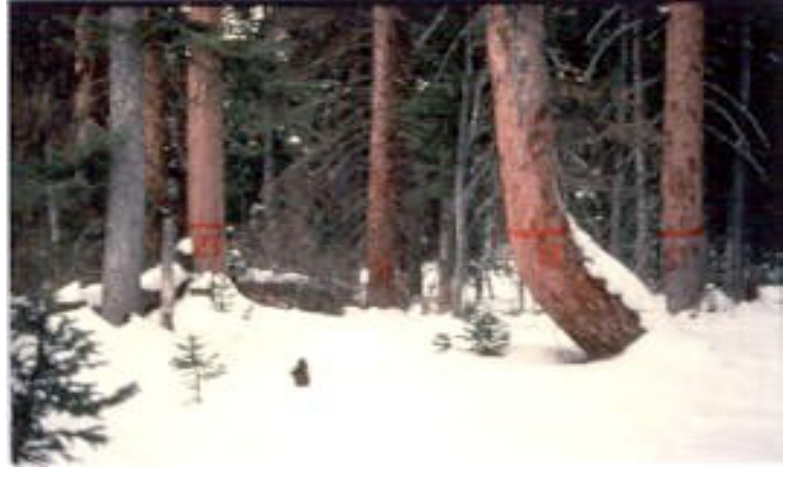
Figure 7. Standing baited Engelmann spruce trap trees marked in orange paint (Photo: A. Steven